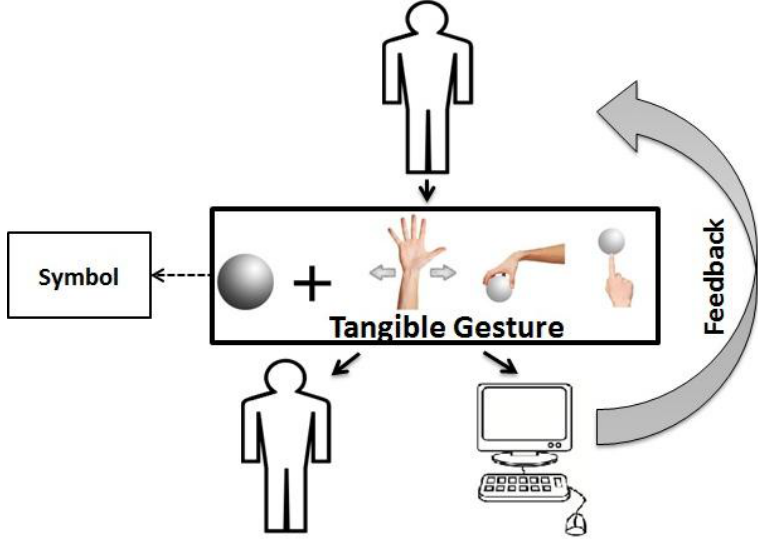
Figure 2. The communication model of tangible gesture interaction. A user performs a tangible gesture, which is a sign with an associated meaning. The computer (and possibly the other users) interprets this sign and acknowledges the user with